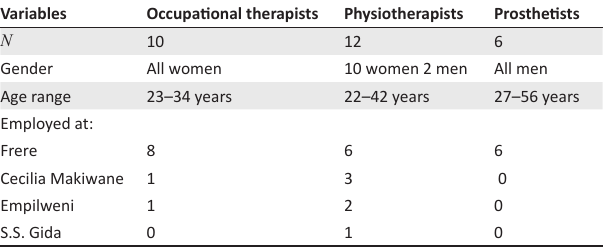
TABLE 2: Background information on study participants. Variables